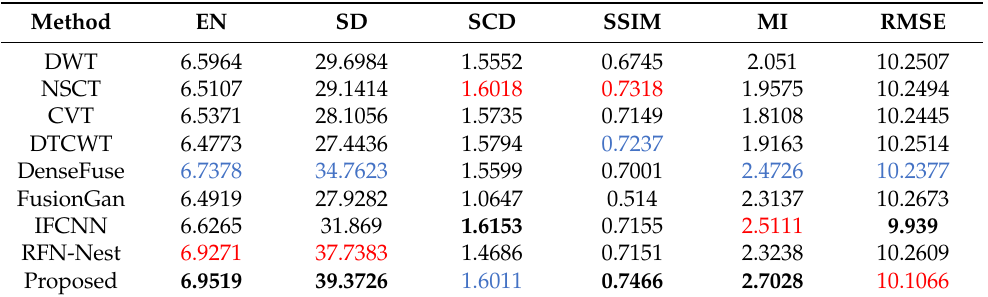
Table 4. Quantitative results on 21 pairs of images from TNO dataset. The best values, the second-best values and the third-best values are indicated in bold, red and blue,